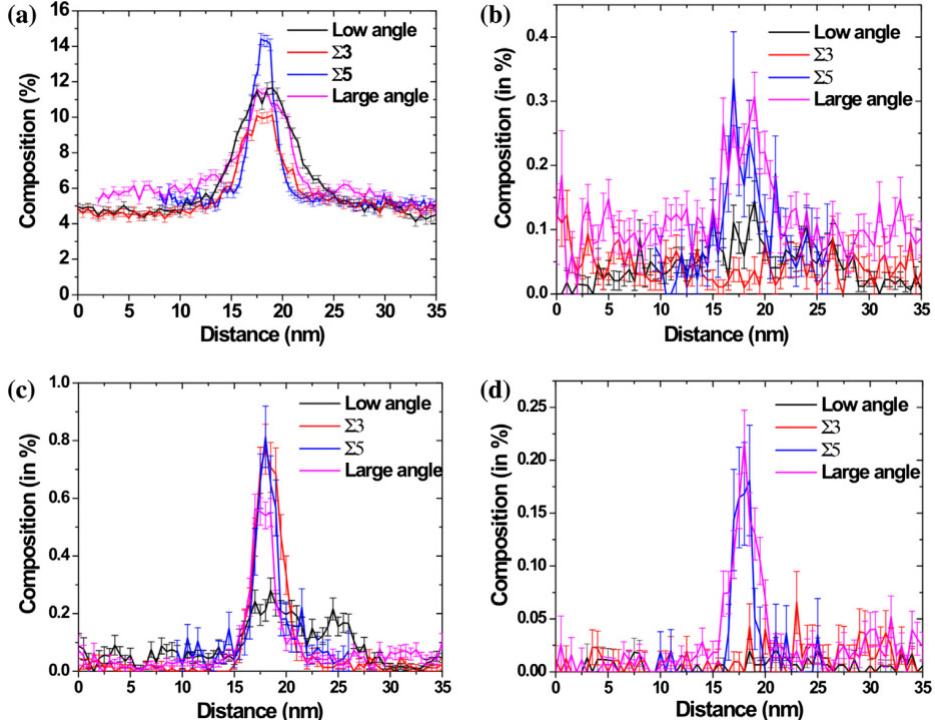
Figure 4. (color online) Distribution profiles of ( a ) Cr, ( b ) C, ( c ) Si and ( d ) P concentration across different types of grain boundaries for neutron-irradiated Fe-6%Cr alloys. (Reprinted with permission from [99]. Copyright 2014 by